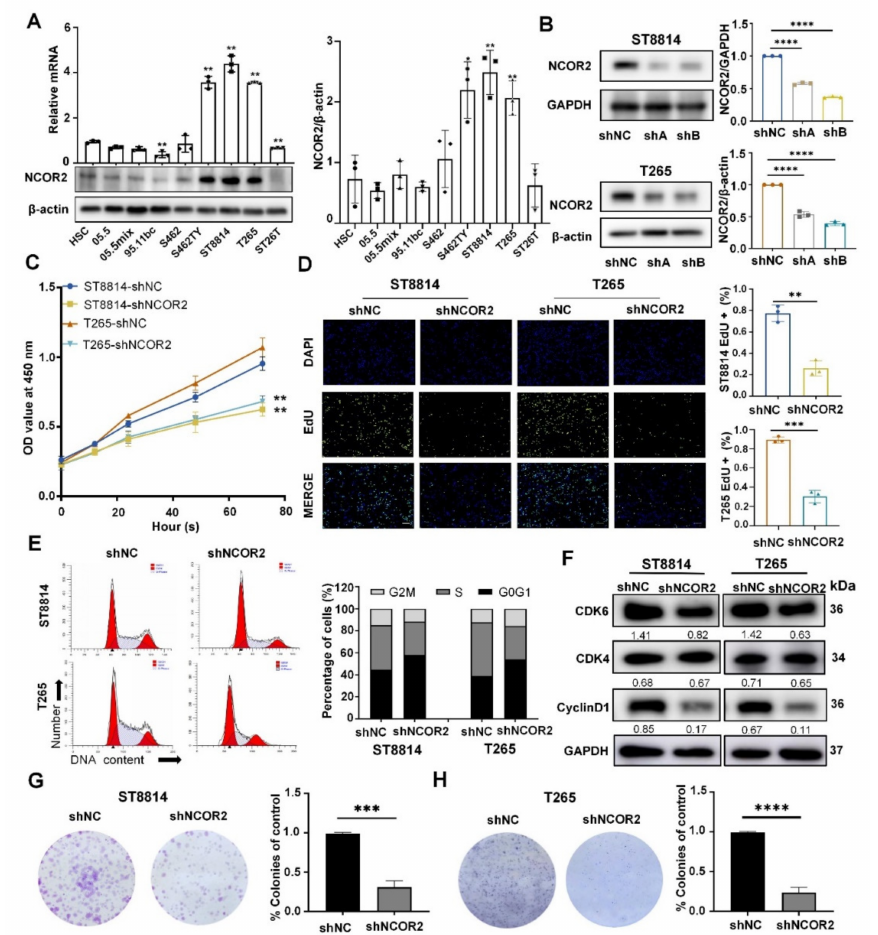
Figure 2. NCOR2 knockdown leads to the inhibition of NF1-derived MPNST cell proliferation in vitro. ( A ) qPCR and WB showing that the NCOR2 mRNA and protein levels in one NHSC, three PNF cell lines, four NF1-derived MPNST cell lines, and one sporadic MPNST cell line; β -actin was used as the control. Data are shown as mean ± S.D., n = 3; * p < 0.05, ** p < 0.005. ( B ) WB showing that the efficacy of NCOR2 knockdown in ST8814 and T265 cells at protein levels; shB was selected for further investigation. GAPDH was used as the control. Data are shown as mean ± S.D., n = 3; **** p < 0.0001. ( C , D ) Significantly decreased cell viability was observed in the shNCOR2 groups by CCK-8 and EdU assays. Data are shown as mean ± S.D., n = 3; ** p < 0.005, *** p < 0.0005. ( E , F ) FCM showing that the cells were mostly arrested in G0/G1 phase in the shNCOR2 groups. Data are shown as mean ± S.D., n = 3. WB showing that the protein levels of CDK6 and cyclin D1 were decreased, respectively. ( G , H ) An evident reduction in the colony formation ability in both ST8814- shNCOR2 and T265- shNCOR2 cell lines. Data are shown as mean ± S.D., n = 3; *** p < 0.0005; **** p <